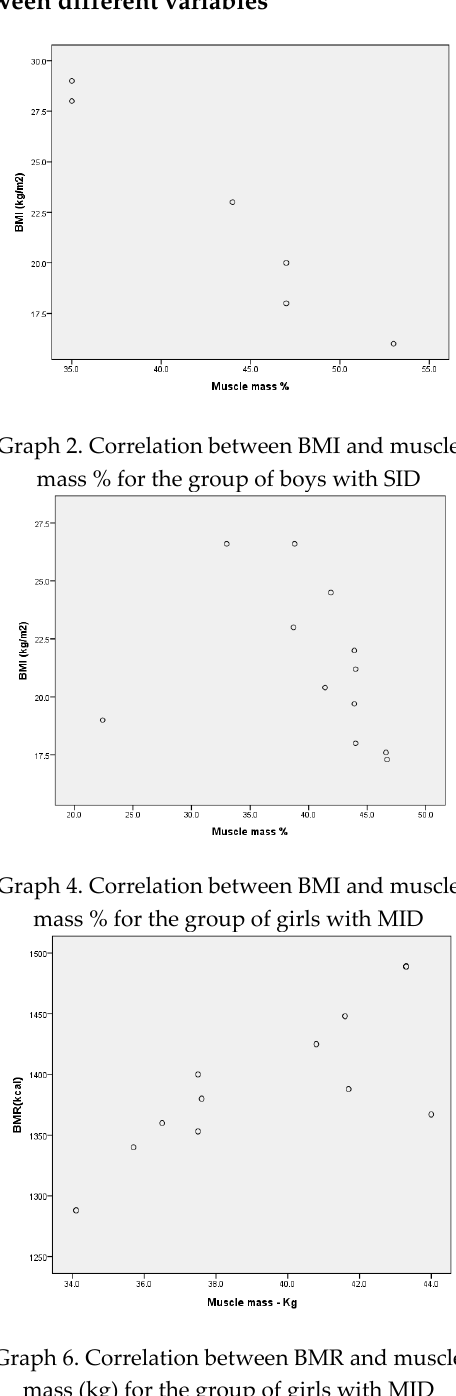
Graph 6. Correlation between BMR and muscle mass (kg) for the group of girls with